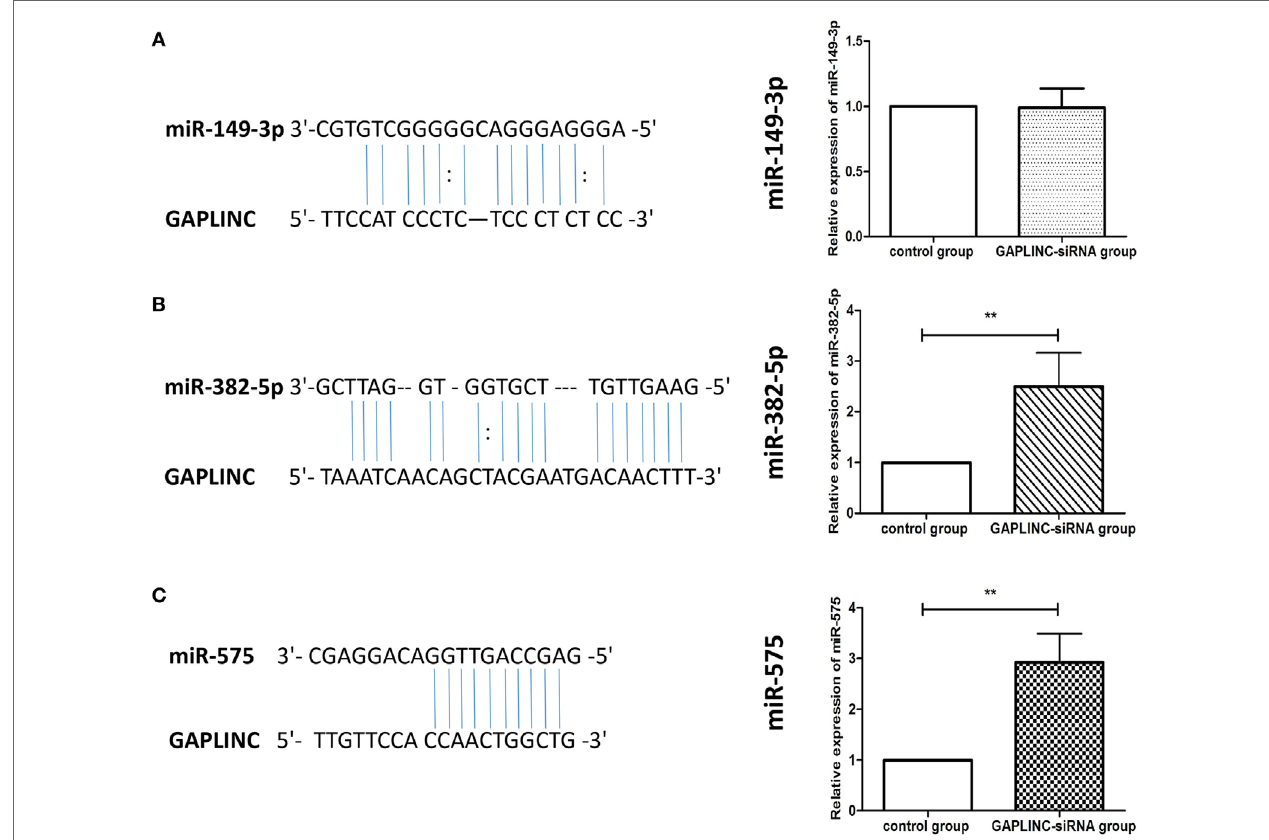
FigUre 5 | The verification of the target microRNAs of LncRNA GAPLINC (miR-149-3p, miR-382-5p, miR-575). In both (a–c) , the left panel shows the potential binding site in the sequences of GAPLINC with relevant microRNA, analyzed through bioinformatics; the right panel identified the relative expression of three microRNAs between negative control and GAPLINC-small interference RNA groups, respectively, measured by quantitative real-time reverse transcription PCR. ** P < 0.01 vs control